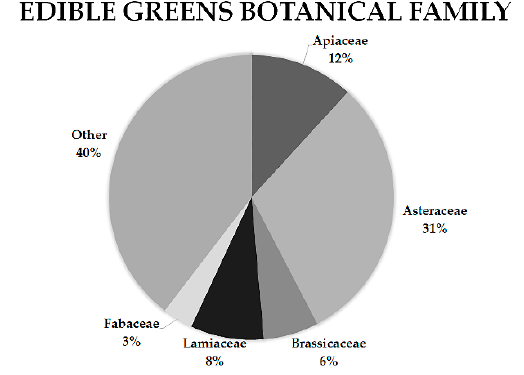
Figure 1. The botanical family of Mediterranean edible greens according to a survey conducted by